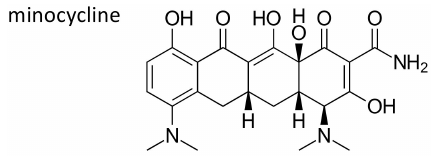
Figure 11. Chemical structure of minocycline.